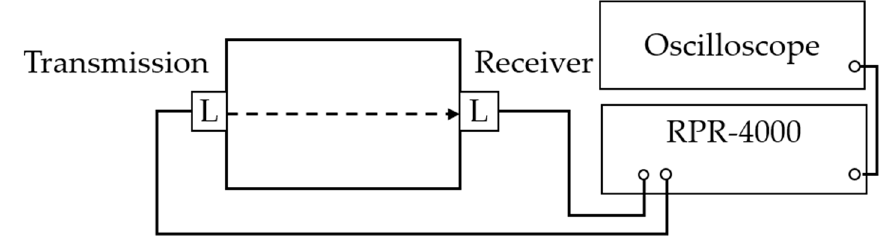
Figure 6. Schematic of higher harmonic longitudinal wave nonlinear testing.